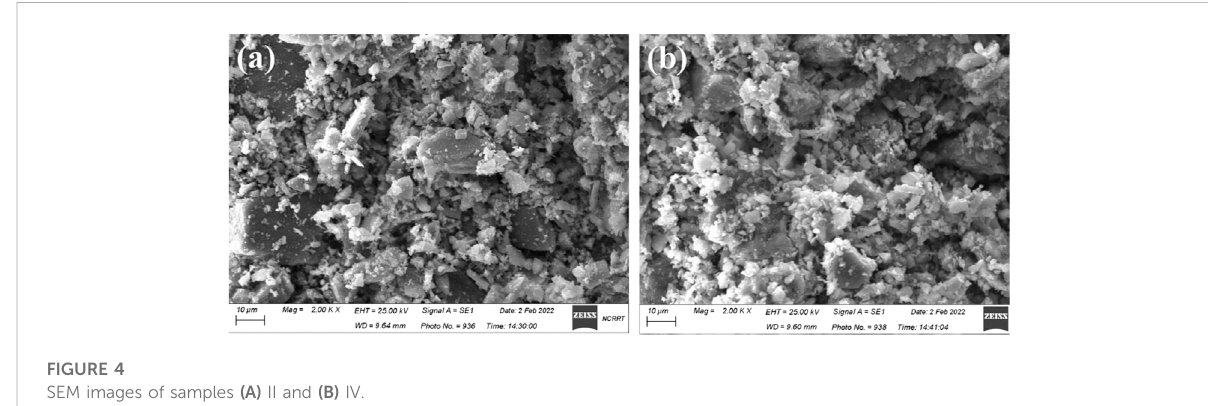
FIGURE 4 SEM images of samples (A) II and (B) IV.